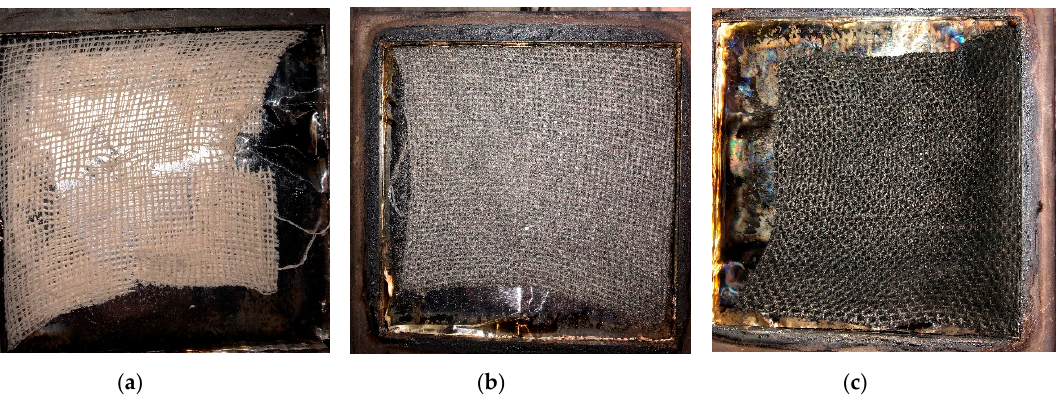
Figure 6. The char residue of ( a ) the Control, ( b ) GnP composite and ( c ) FR composite after the cone